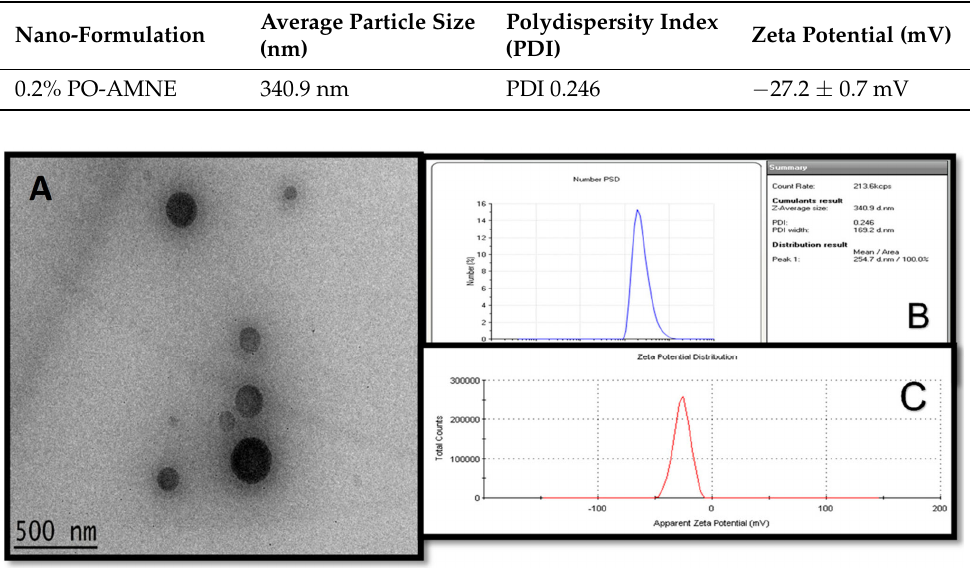
Figure 3. Representation of morphology of the optimized (0.2%) PO-AMNE ( A ), particle size distribution ( B ), and zeta potential ( C ).